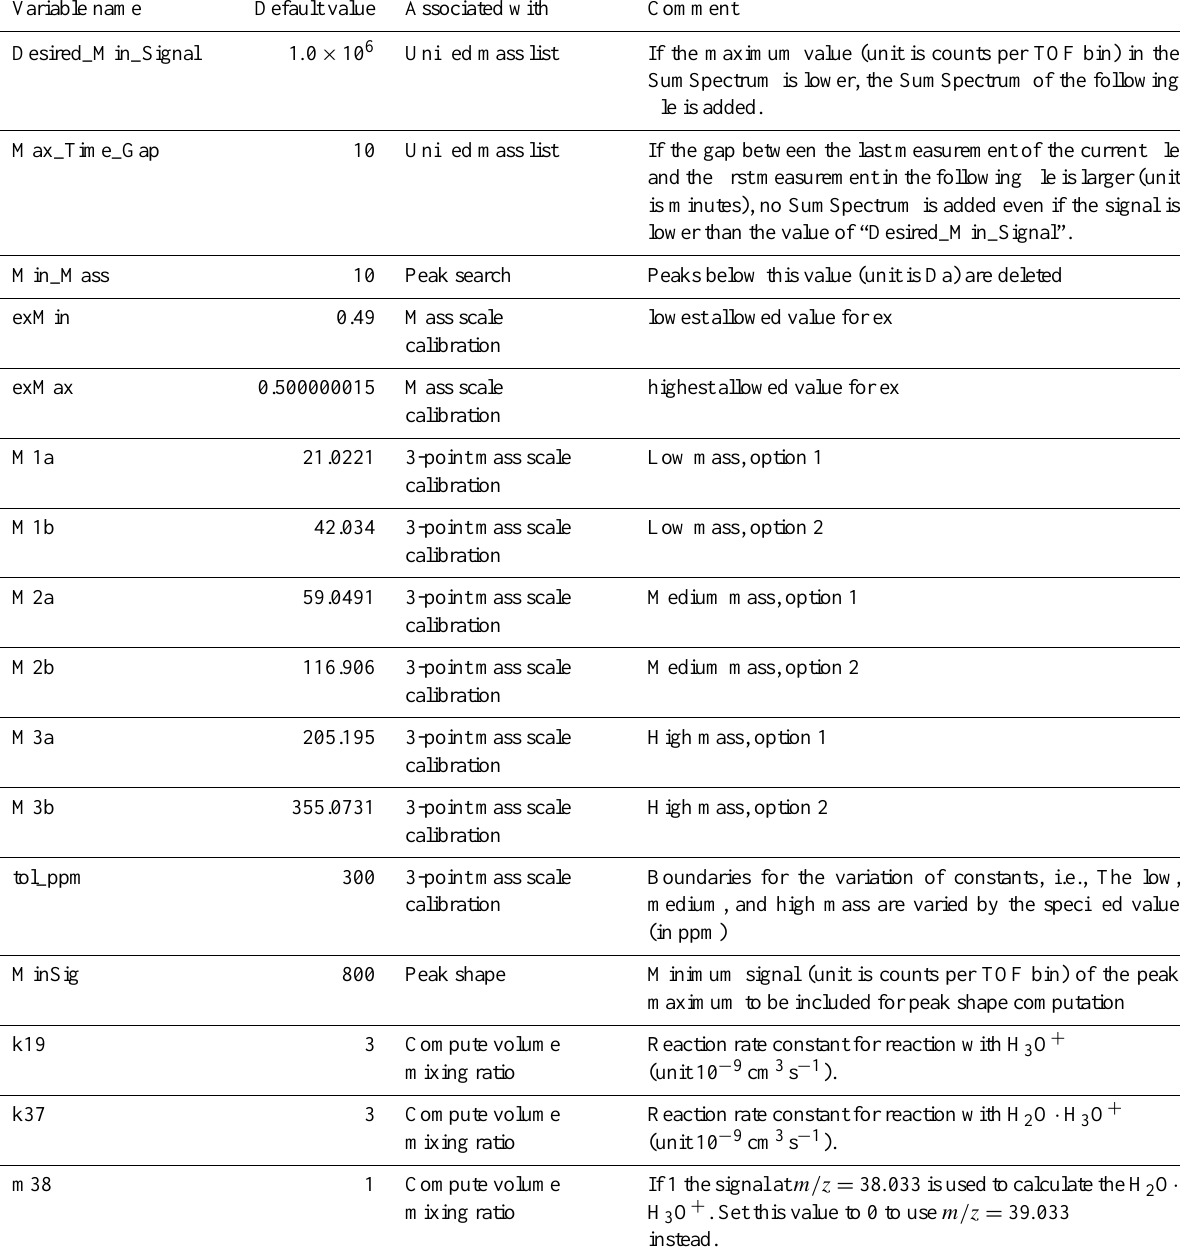
Table D1. List of adjustable